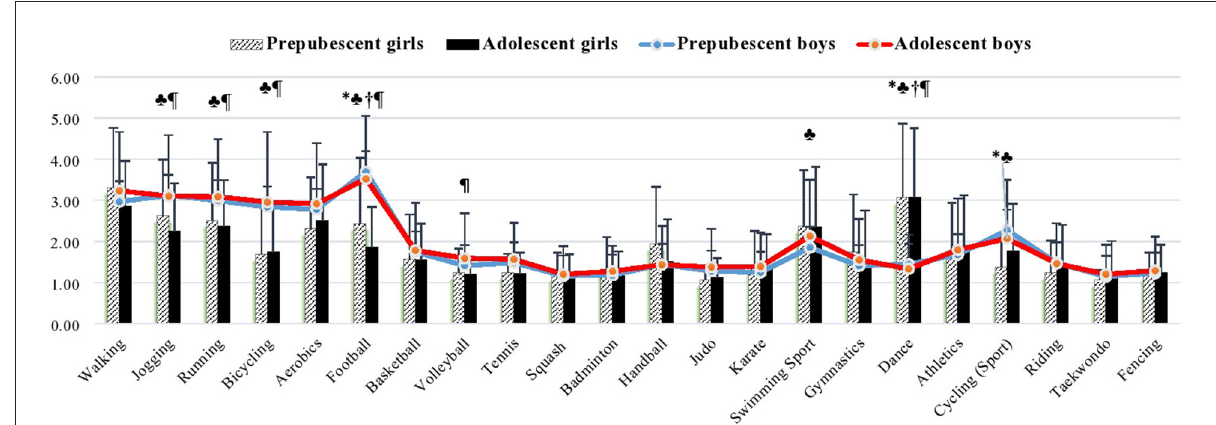
FIGURE1 Mean value of physical activity in spare-time for Saudi students stratified by sex and age. * significant difference in prepubescent boys vs. prepubescent girls; ♣ significant difference in prepubescent boys vs. adolescent girls; † significant difference in adolescent boys vs. prepubescent girls; ¶ significant difference in adolescent boys vs. adolescent girls. Physical activity questionnaire for older children PAQ-C (Kowalski et al., 2004), scored on a 5-point scale; 1 corresponds to lowest PA, and 5 corresponds to highest PA. The values of PA are presented as means ( ±